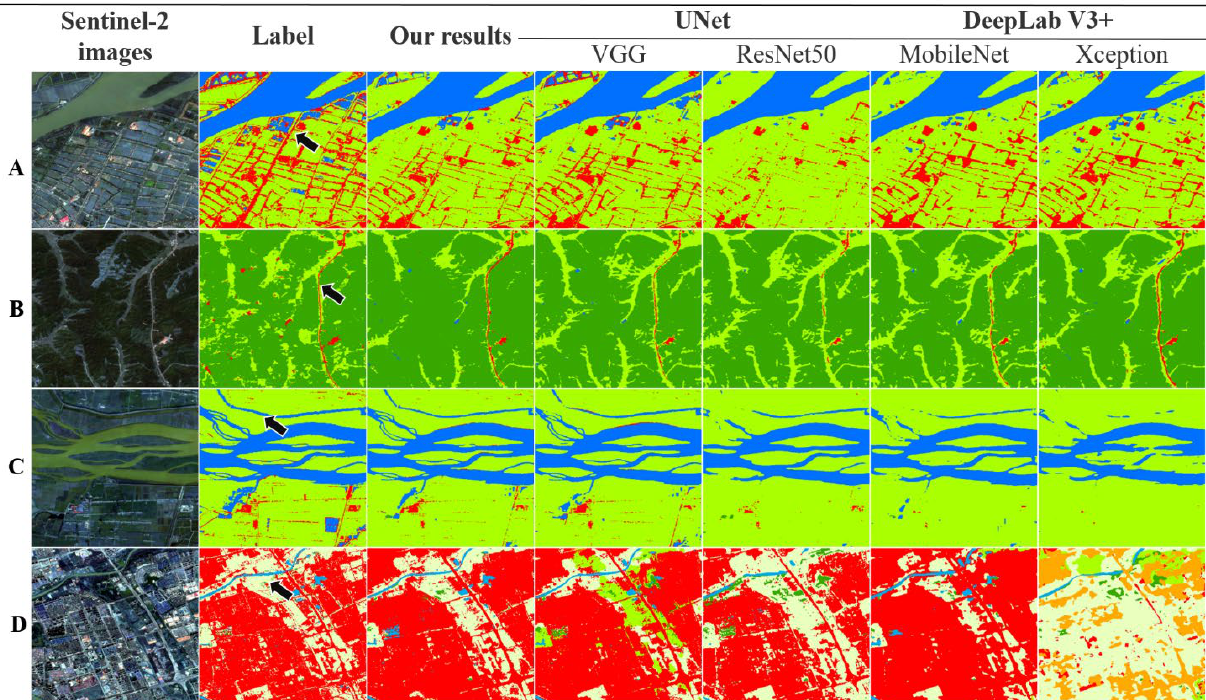
Figure 3. Comparison of the results of different classification methods with rural ( A ), mountainous ( B ), riverine ( C ), and urban ( D ).